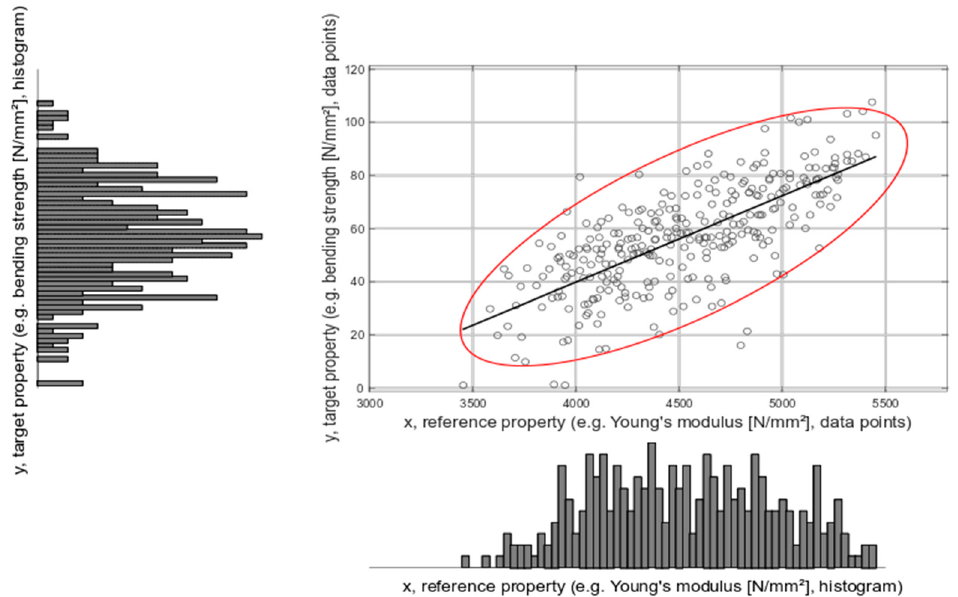
Figure 2. Exemplary scatter plots of reference and target variable with 95% confidence interval error ellipse and linear regression graph.